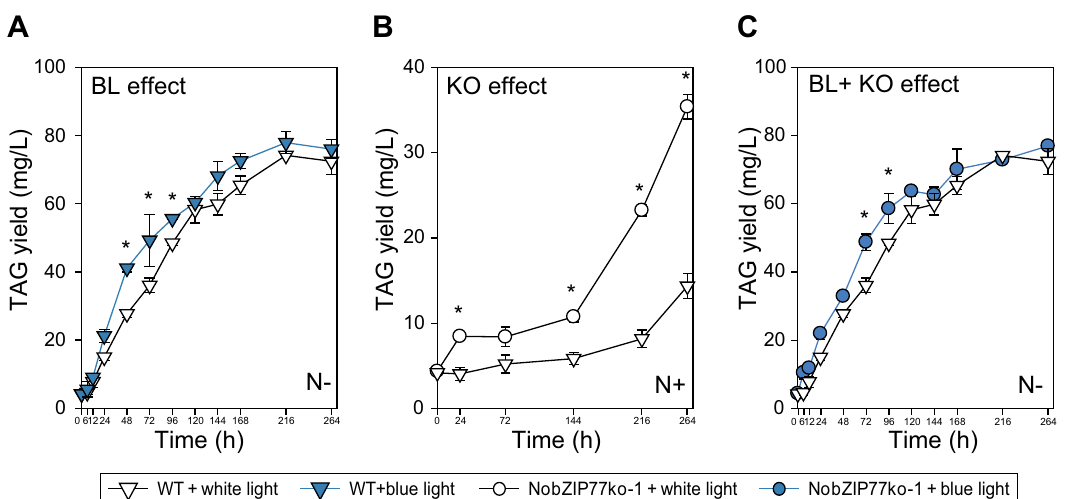
Fig. 5 A rational approach to elevate oil productivity by exploiting the NobZIP77 signaling. Three independent cultures were sampled for a period of 11 days. For each of the three independent sets of samples, TAG contents and yields were quanti fi ed by single-cell Raman microspectroscopy, based on the protocols that we have published. The results yield very small error bars. TAG yield (mg/L) was compared between wild-type (WT) under white light (WL) and blue light (BL) plus N − ( A ), WT and NobZIP77ko-1 (KO) under WL and N + ( B ), or WT-BL and KO-BL under N − ( C ). Data are represented as mean ± SD ( n = 3 biologically independent samples). *: signi fi cant change ( p ≤ 0.05) by one-sided Student ’ s t -test versus WT-WL. Source data are provided as a Source data fi